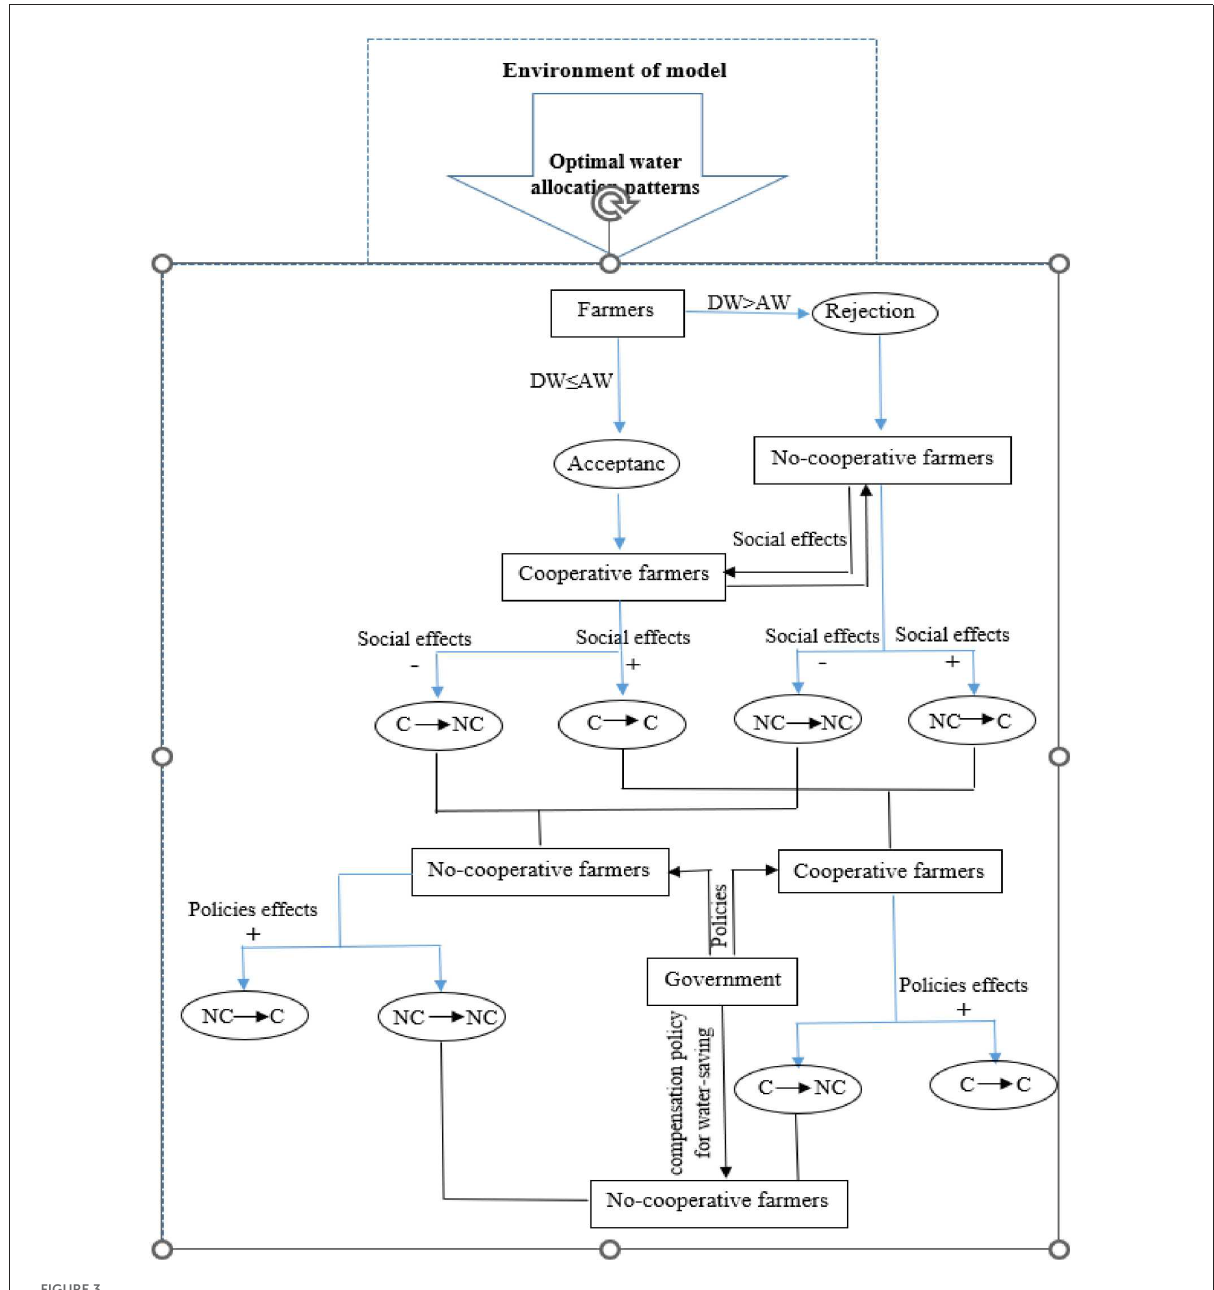
FIGURE3 Structure of the proposed agent-based